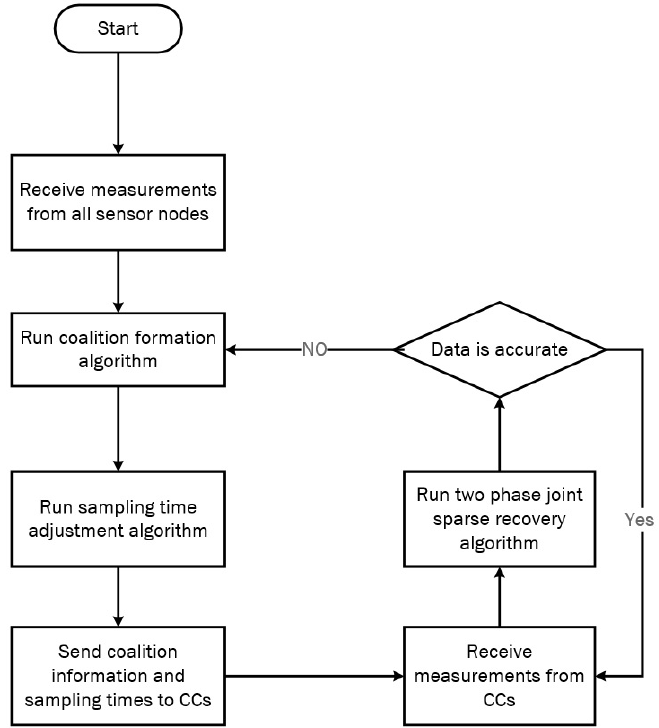
Figure 6. Approach overview